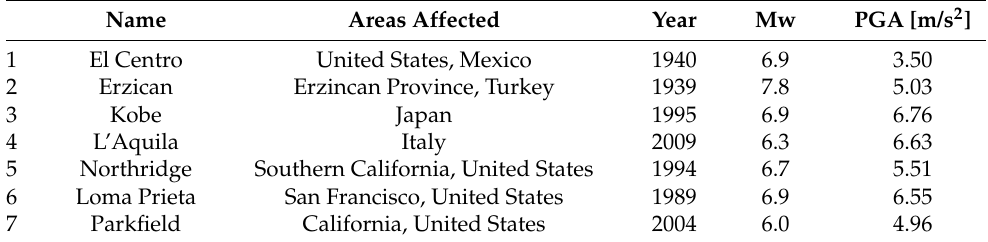
Table 5. List of the earthquakes adopted in the analysis.